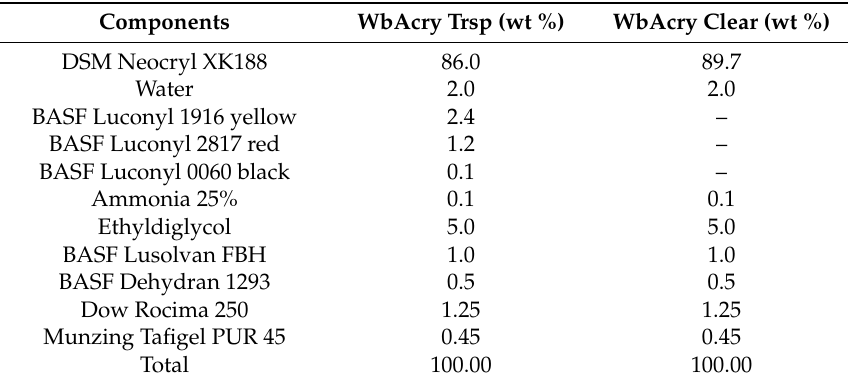
Table 3. Description of the waterborne acrylic